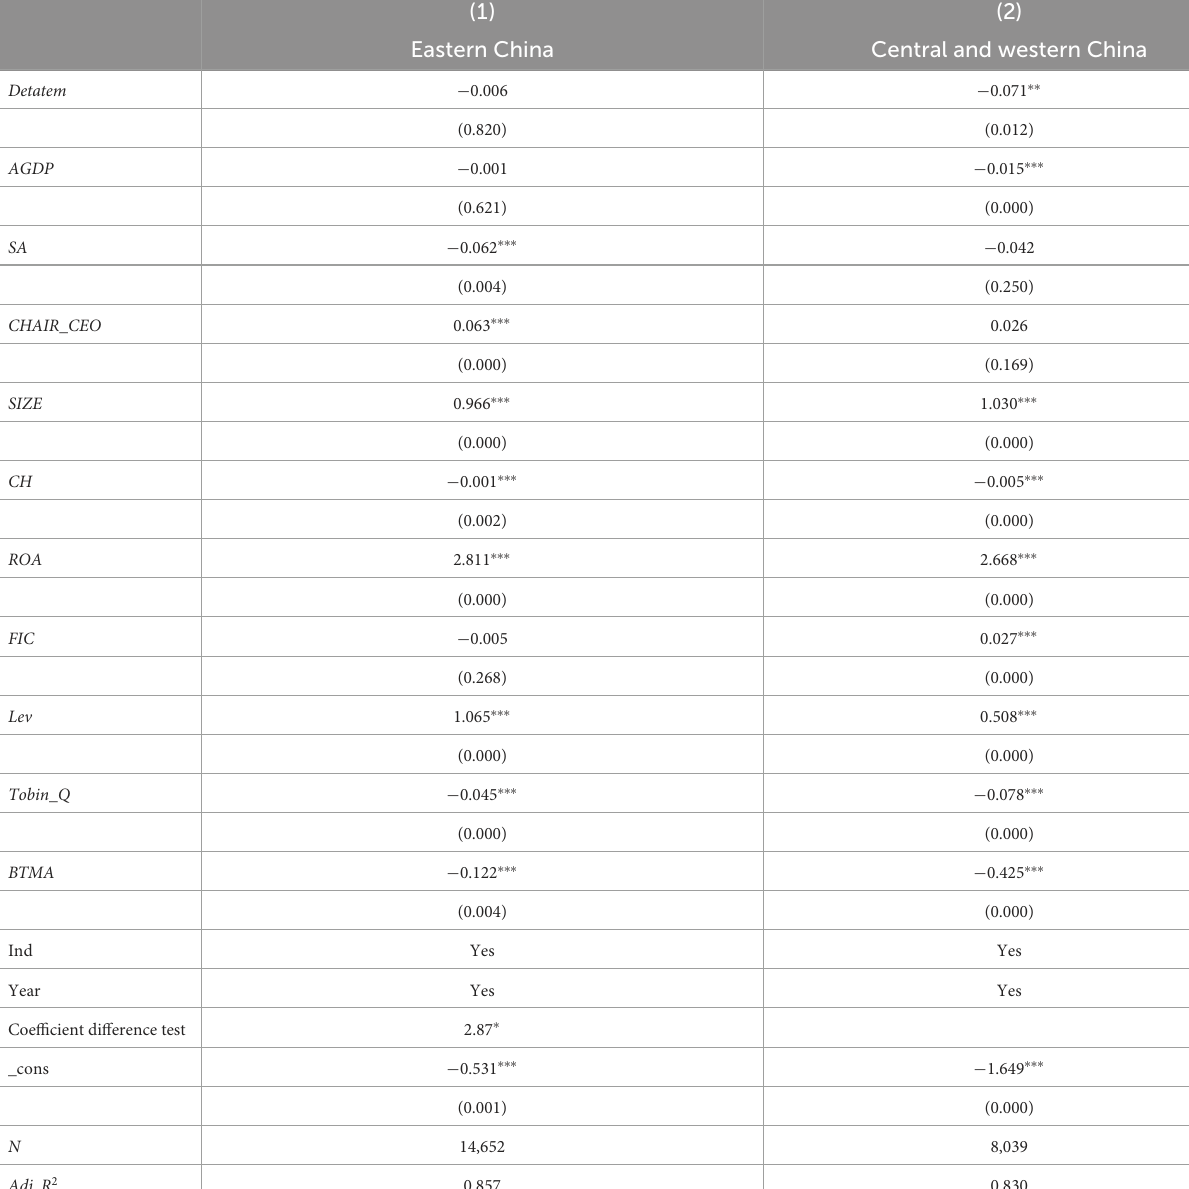
TABLE 10 Climate change, regional economy, and sales revenue.